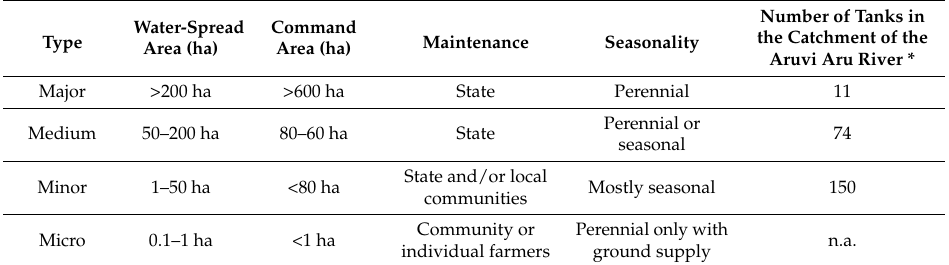
Number of Tanks in the Catchment of the Aruvi Aru River *